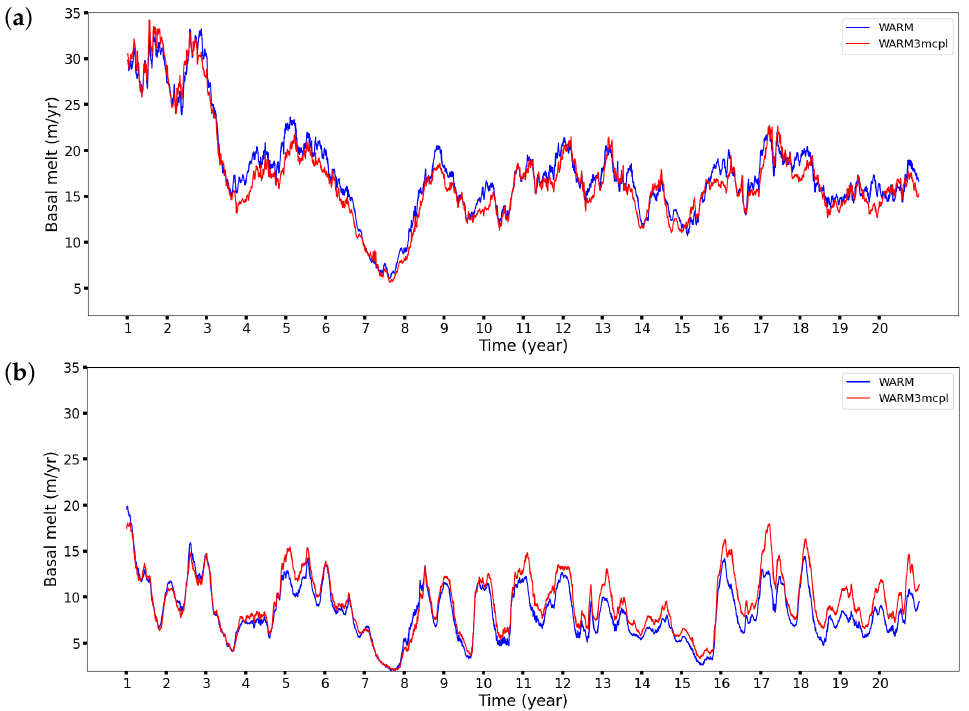
Figure 13. Area-averaged basal melt rates of the TIS ( a ) and MUIS ( b ) cavities for the WARM (blue) and WARM3mcpl (red) simulations over the 1995–2014 period. The TIS mean basal melt rate amounts to 18.63 ± 6.71 m year − 1 for WARM and 17.83 ± 7 m year − 1 for WARM3mcpl. The MUIS mean basal melt rate amounts to 8.77 ± 3.38 m year − 1 for WARM and 9.09 ± 3.46 m year − 1 for WARM3mcpl. REF3mcpl and WARM3mcpl do not start from a balanced coupled state but